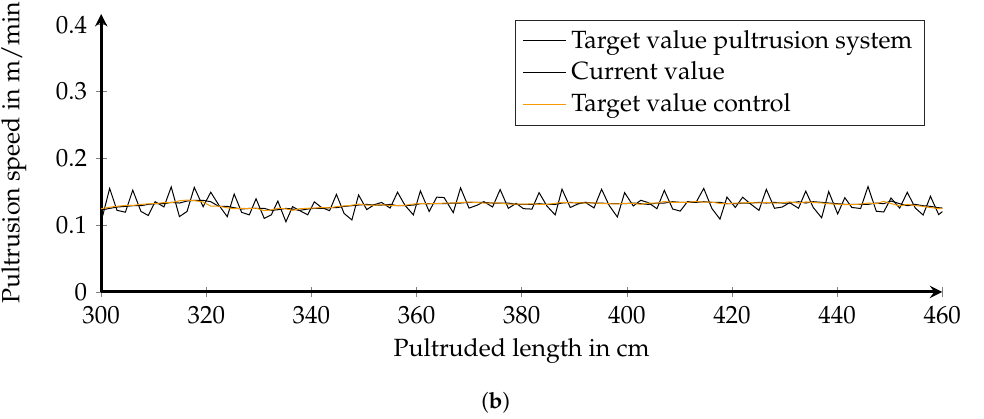
Figure 10. Experimental results of the pultrusion control unit for a pultrusion at 140 ◦ Cover the length of the pultruded material between 300and 460cm. ( a ) Sensor signal between 300 and 460 cm; ( b ) pultrusion speed between 300 and 460cm.